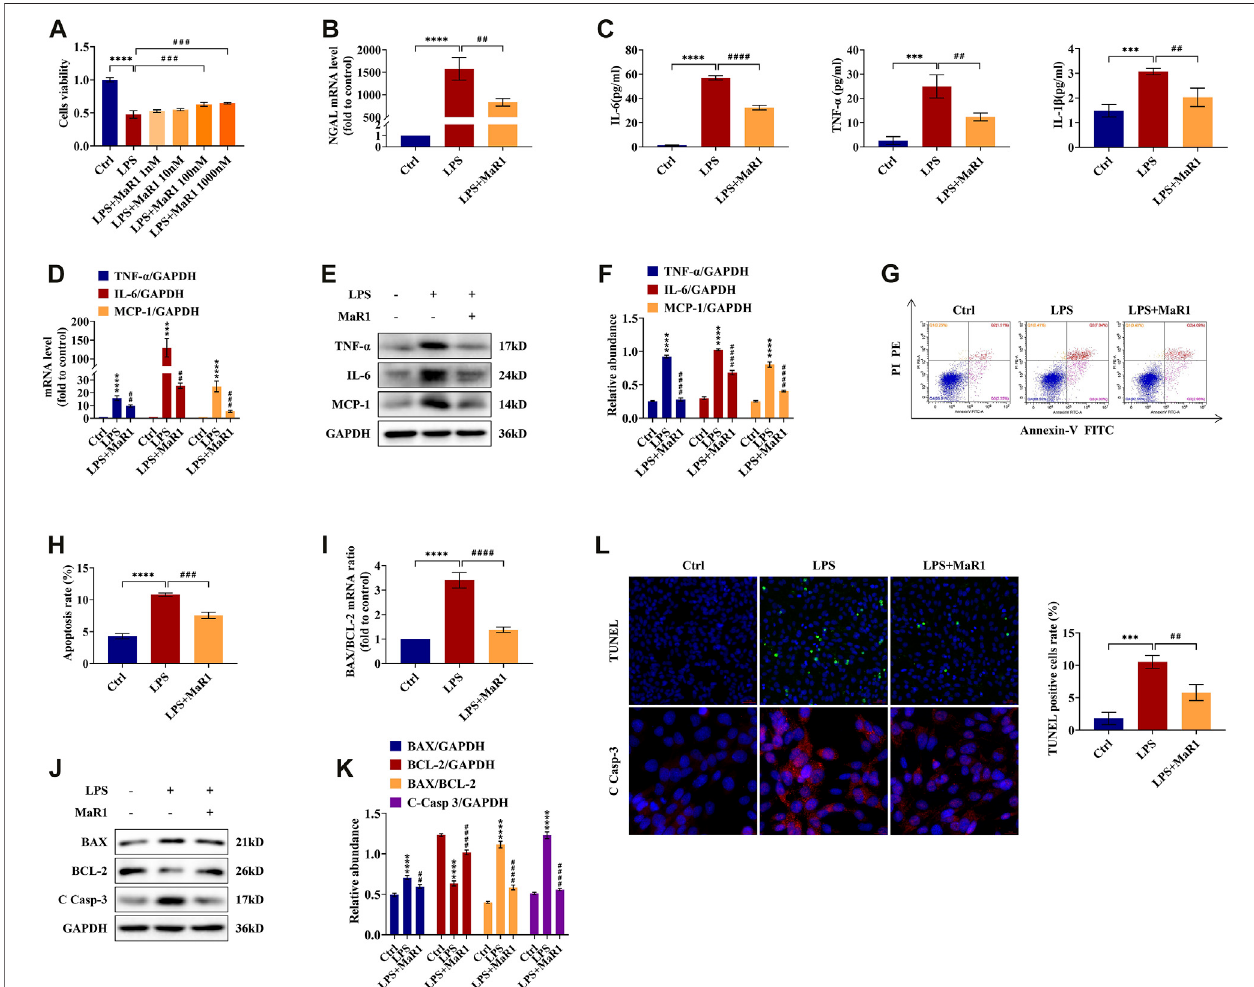
FIGURE 5 | MaR1 promoted cell survival and prevented the in fl ammation and apoptosis of lipopolysaccharide (LPS)-stimulated TCMK-1 cells. (A) The effects of LPS (100 μ g/ml) and MaR1 (1, 10, 100, and 1,000 nM) on TCMK-1 cells were determined using CCK-8. (B) The gene expression of NGAL in TCMK-1 cells was quantitated using qRT-PCR. (C) Thecell supernatant levels ofIL-6 and TNF- α , and IL-1 β weredetermined using assay kits ineach group ofTCMK-1 cells. (D) The gene expressions of TNF- α , IL-6, and MCP-1 in TCMK-1 cells were quantitated using qRT-PCR. (E) The expressions of TNF- α , IL-6, and MCP-1 in TCMK-1 cells were analyzed using Western blot. (F) The protein levels of TNF- α , IL-6, and MCP-1 were normalized with GAPDH. (G) Flow cytometry analysis of apoptosis using Annexin V-FITC and PI staining. (H) Percentage of apoptosis in each group of TCMK-1 cells. (I) The gene expression ratio of BAX/BCL-2 in TCMK-1 cells was quantitated using qRT-PCR. (J) The expressions of BAX, BCL-2, and C Casp-3 in TCMK-1 cells were analyzed using Western blot. (K) The protein levels of BAX, BCL-2, and C Casp-3 were normalized with GAPDH. (L) TUNEL staining (scale bar (cid:2) 50 μ m), percentage of TUNEL-positive cells (%), and immuno fl uorescence staining of C Casp-3 expression (scalebar (cid:2) 20 μ m)ofTCMK-1cells(timepoint: 24 h).Dataarepresented asmean ± SD, n (cid:2) 5.* p < 0.05,** p < 0.01, *** p < 0.001,**** p < 0.0001 vs .control group; # p < 0.05, ## p < 0.01, ### p < 0.001, #### p < 0.0001 vs . LPS group.